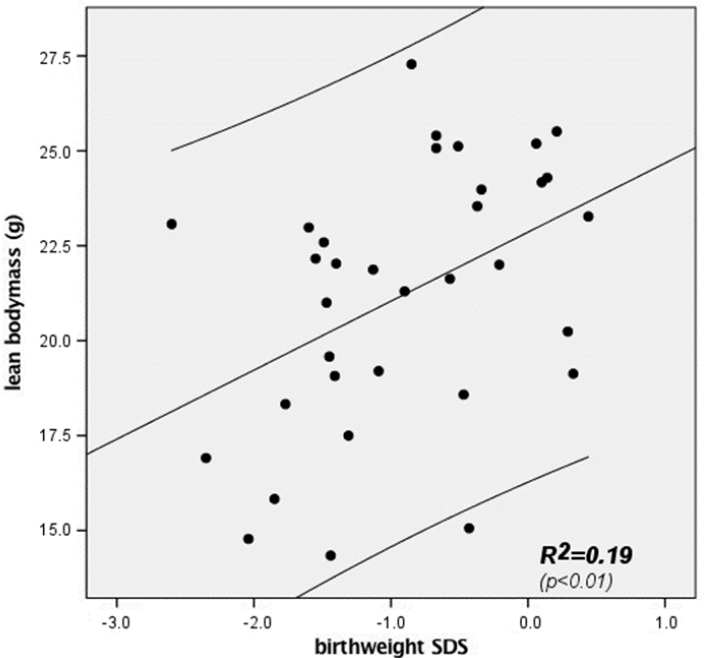
Figure 1. Correlation between birth weight and lean body mass in former ELBW subjects at 9.5 years of age. Lines represent the regression line and the upper and lower limit of the 95% confidence interval ( n = 35). Table 2. Stepwise linear regression analyses of body composition and metabolic parameters in former ELBW infants at 9.5 years of age ( n = 30).